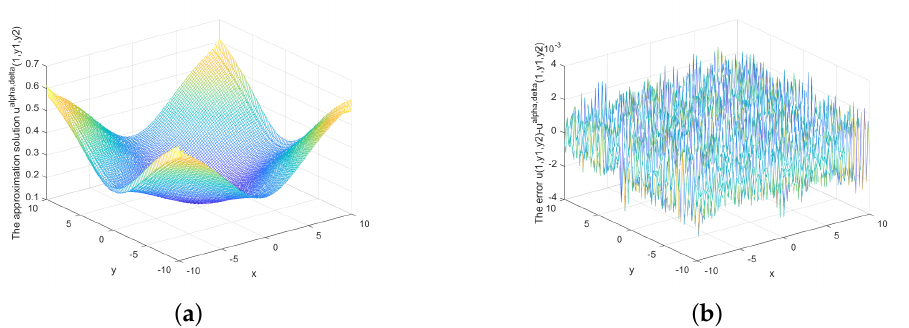
Figure 13. ( a ) The regularized solution and ( b ) error between regularized and exact solution when x = 0.3, δ = 1 × 10 − 5 under a priori rule.